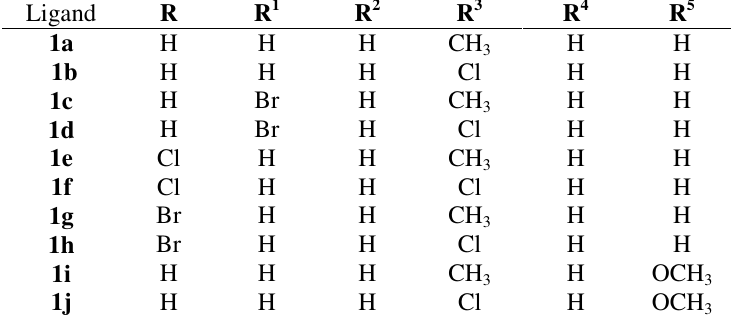
Table 1. Detailed structure of 2-phenyl-4 H